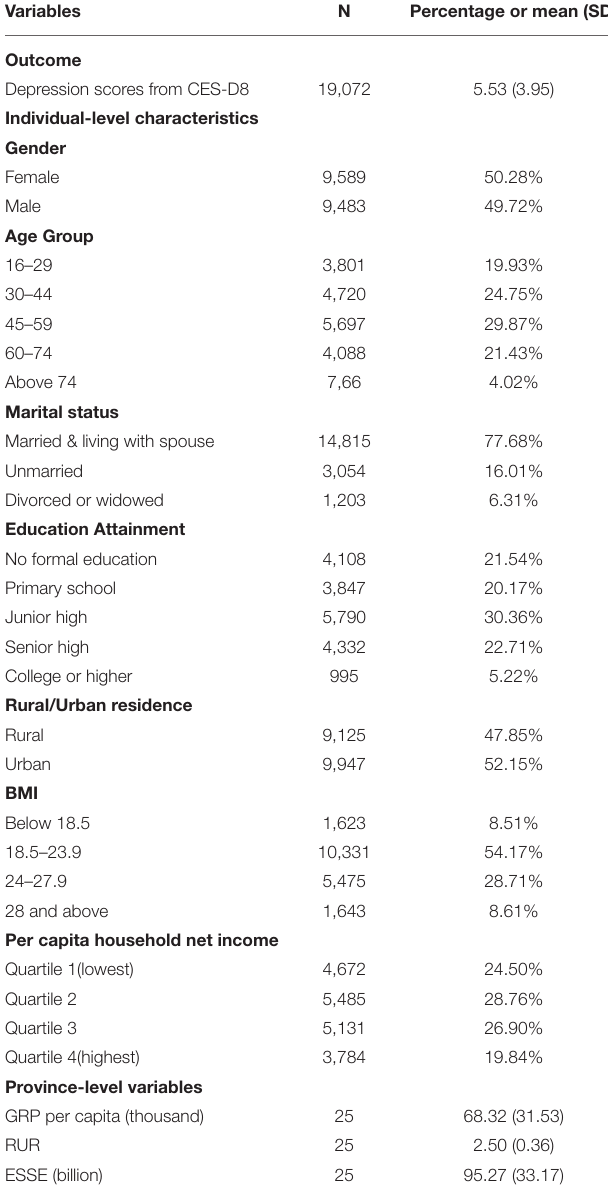
TABLE 1 | Basic characteristics for the individual- and province-level